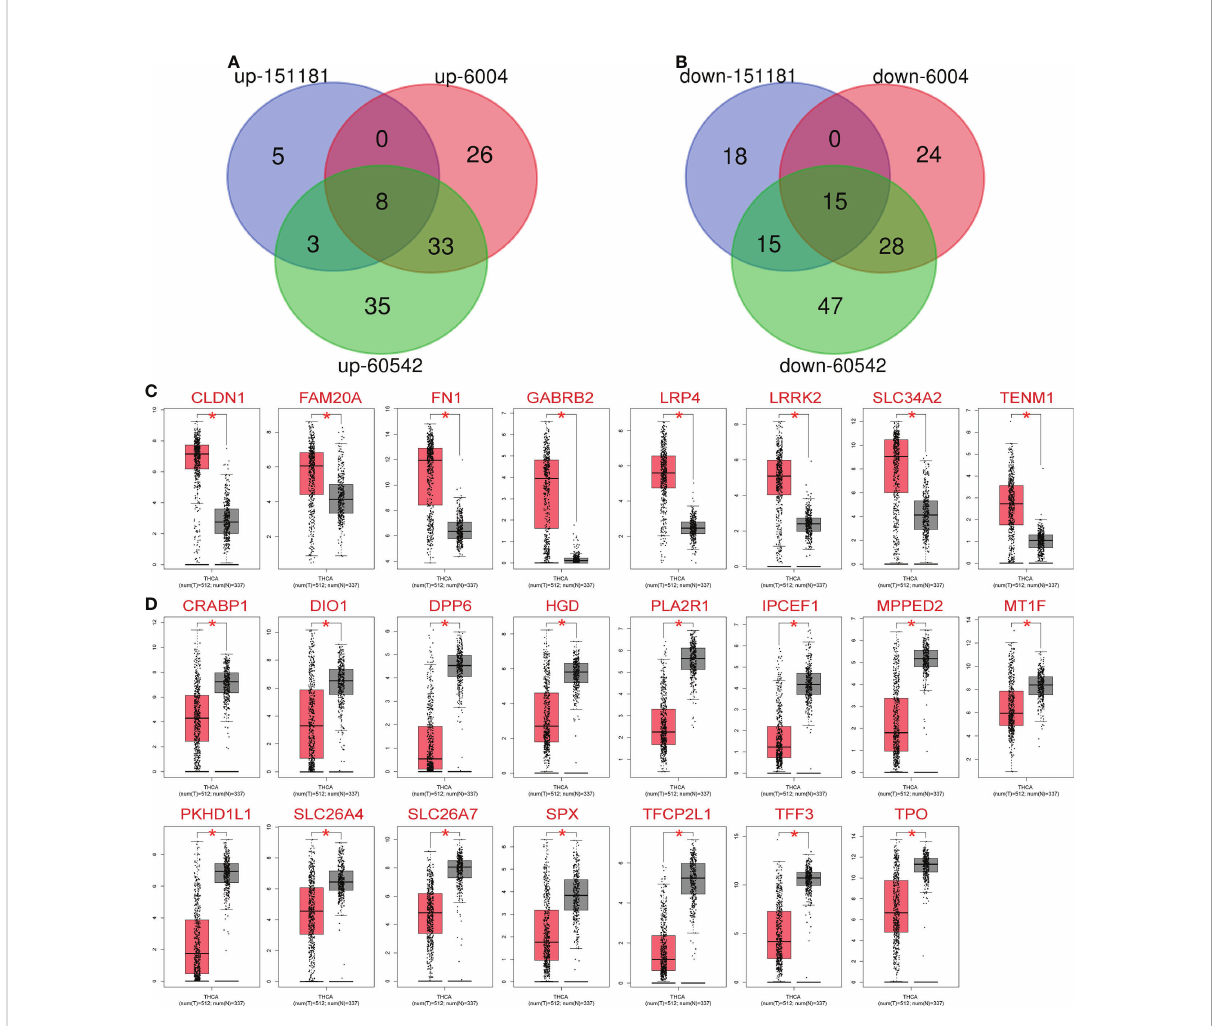
FIGURE 1 Expression of 23 differentially expressed genes (DEGs) in metastatic PTC and non-cancer tissues. (A) Common upregulated intersection DEGs obtained from Gene Expression Omnibus database: GSE15181, GSE6004 and GSE60542. (B) Common downregulated intersection DEGs obtained Gene Expression Omnibus database: GSE15181, GSE6004 and GSE60542. (C) Upregulated DEGs expression in thyroid cancer (TC) patients and normal controls. (D) Downregulated DEGs expression in TC patients and normal controls. Red: Cancer, black: Normal, *P < 0.05 vs. normal